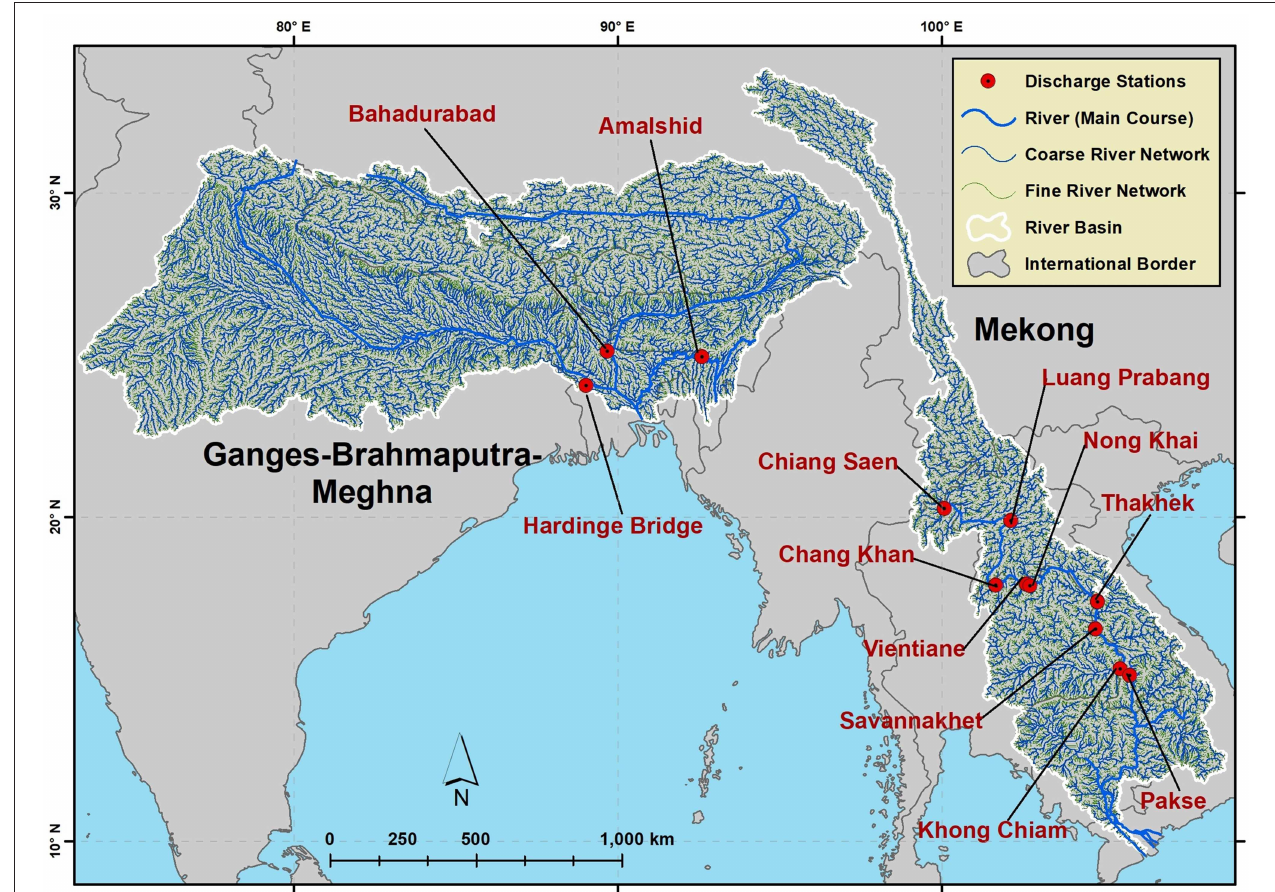
FIGURE 1 | Location of the Ganges-Brahmaputra-Meghan (GBM) and Mekong river basins along with the in-situ discharge stations. The fine and coarse river networks used for flow routing are shown in the